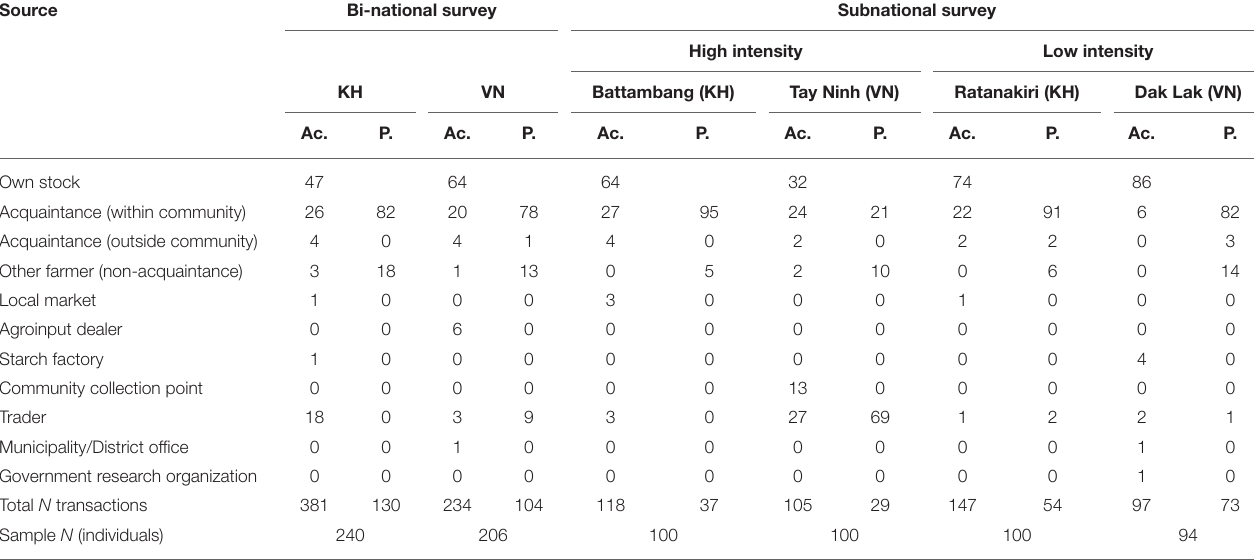
TABLE 4 | Seed source and acquisition types reported in Cambodia (KH) and Vietnam (VN) in 2016, presented as percentages of total recorded seed exchanges. Source